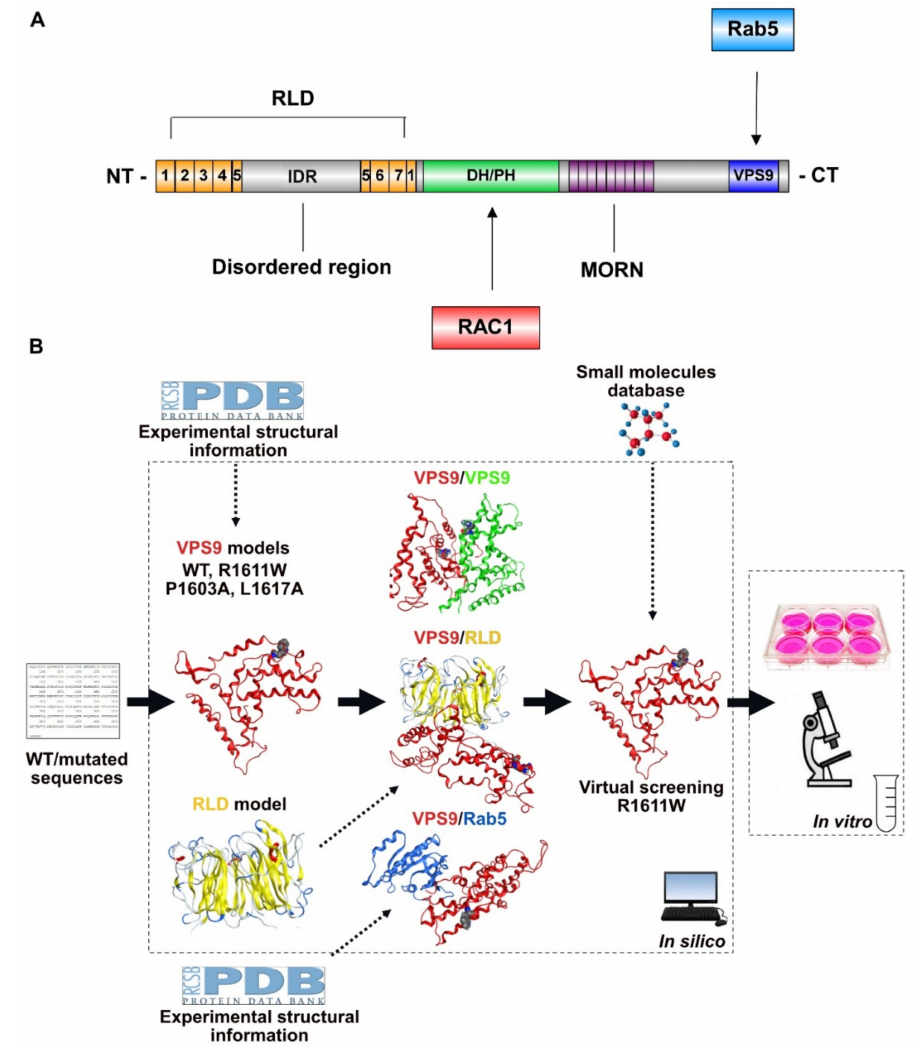
Figure 1. Alsin’s structure and our strategy. ( A ) Schematic representation of hitherto identified alsin domains and key interaction partners. ( B ) Schematic representation of our strategy. WT and